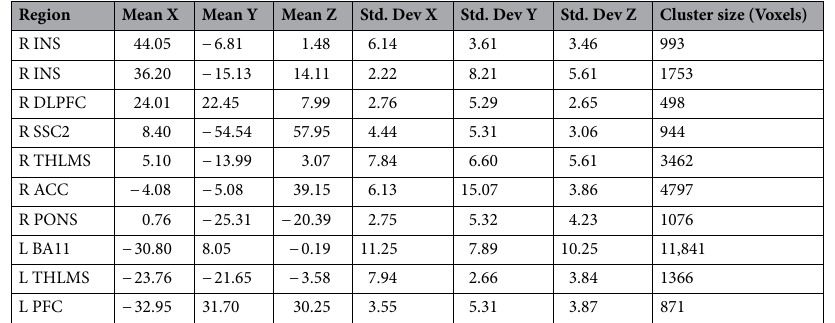
Table 1. VOI of previous study in Talairach coordinates. Several regions that were seen in a previous study linked with pain modulation with specific Talairach coordinates. Indication of left or right given as L or R respectively. INS insula, DLPFC dorsal lateral prefrontal cortex, SSC somatosensory cortex, THLMS thalamus, ACC anterior cingulate cortex, PFC prefrontal cortex, BA Brodmann